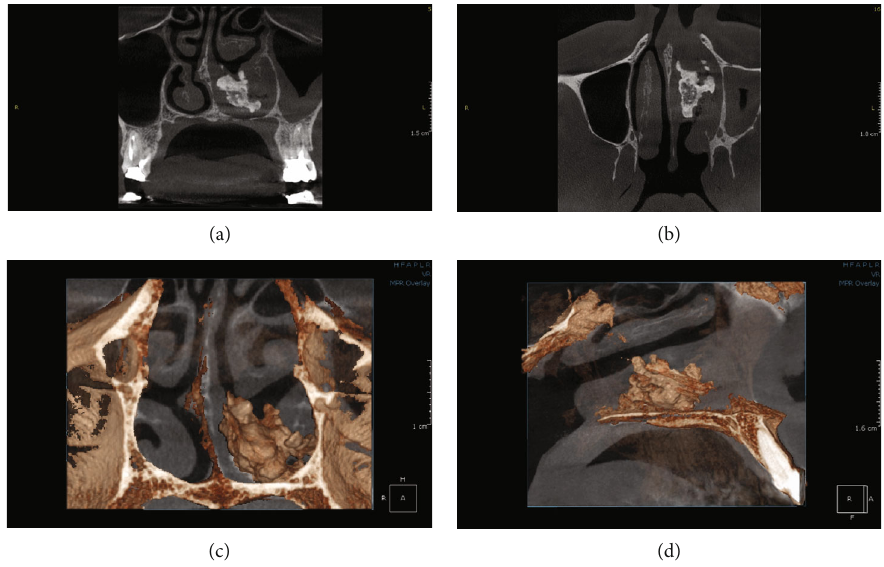
Figure 1: CBCT images of nasal fossa. Coronal (a), axial (b), and multiplanar reformat images show an irregularly large heterogenous calci fi ed mass in the inferior meatus of the left nasal cavity. Note the adjacent mucosal thickening. Coronal (c) and sagittal (d) 3D reformation images better show the space occupying rhinolith and slight deviation of nasal septum to the right